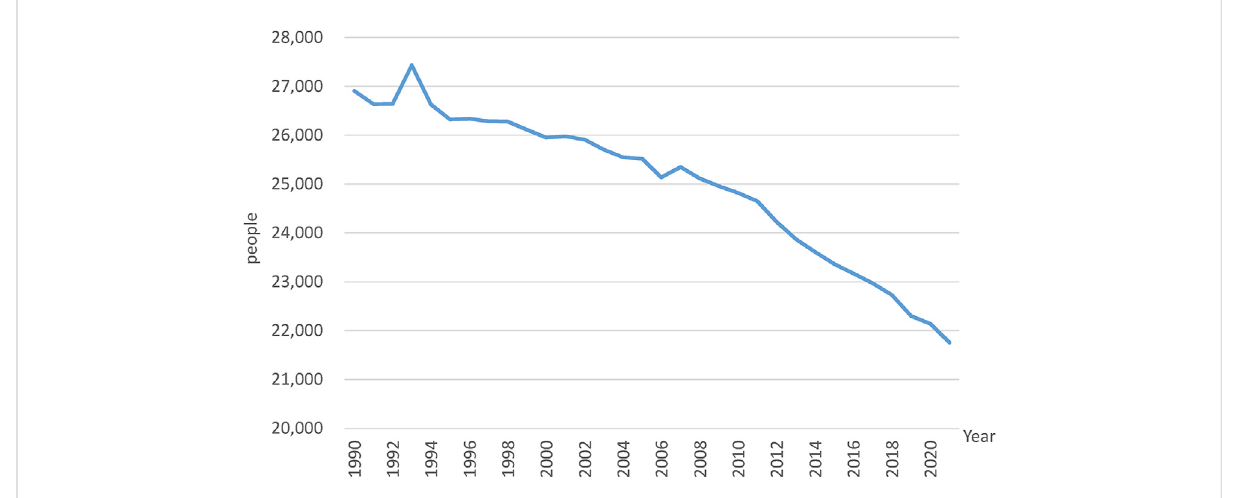
FIGURE 4 Change in the population of Cigu District over the years. Source: Department of Budget, Accounting and Statistics of Tainan City